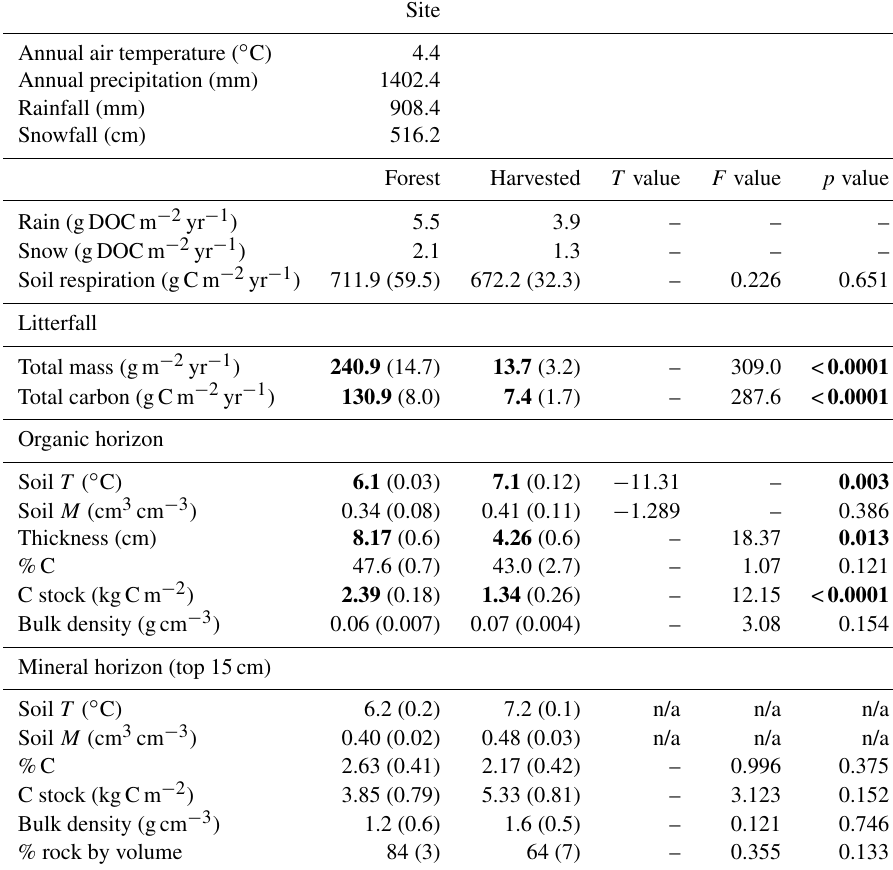
Table 1. Ecosystem and soil properties of black spruce forest and adjacent harvested plots. Values are means of 12 litterfall traps per plot type, 16 soil respiration collars per plot type, three organic (O) horizon soil temperature and moisture probes per plot type, two mineral horizon soil temperature and moisture probes per plot type, nine O horizon samples per plot type used to determine thickness, %C, C stock, C:N and bulk density, one snow pit per plot type, and three seasonally distinct rain collections used together with annual rainfall to estimate an annual C input, with standard error in parenthesis. Results for one-way ANOVAs (litterfall, O horizon thickness, soil%C, C stock, C:N, and soil bulk density) and T tests (soil temperature and moisture) conducted to identify plot type differences are shown where applicable with significant results in bold (alpha = 0.05). Soil moisture is measured as volumetric water content (VWC). See methods for further measurement and sample collection